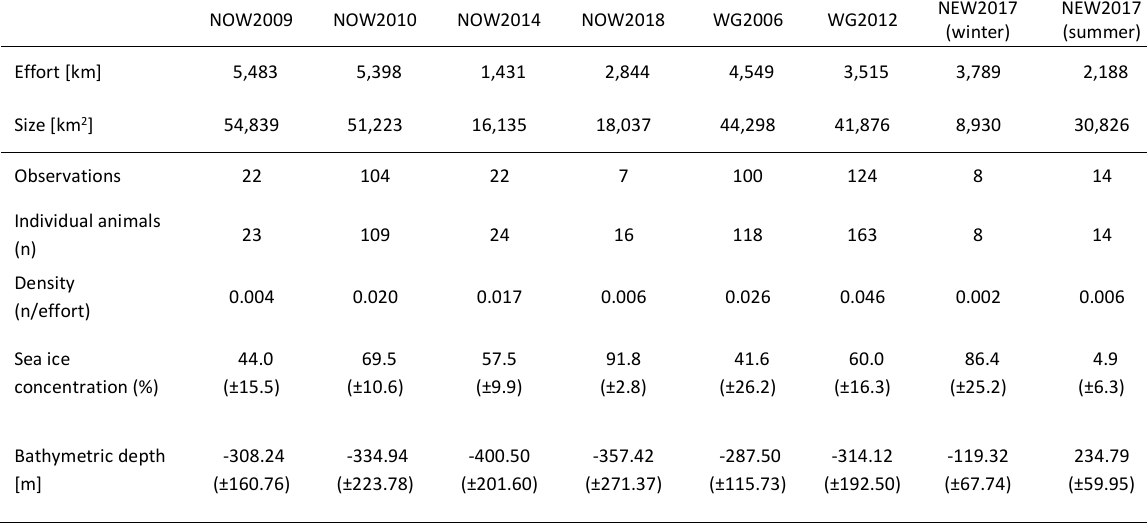
Table 1: Some characteristics of the surveys and observations of bearded seal surveys mentioned above (Heide-Jørgensen et al., 2013, 2016; Scherdin et al., 2020). Bathymetric depth and sea ice concentration describe the mean values of cell grids in which an observation was made